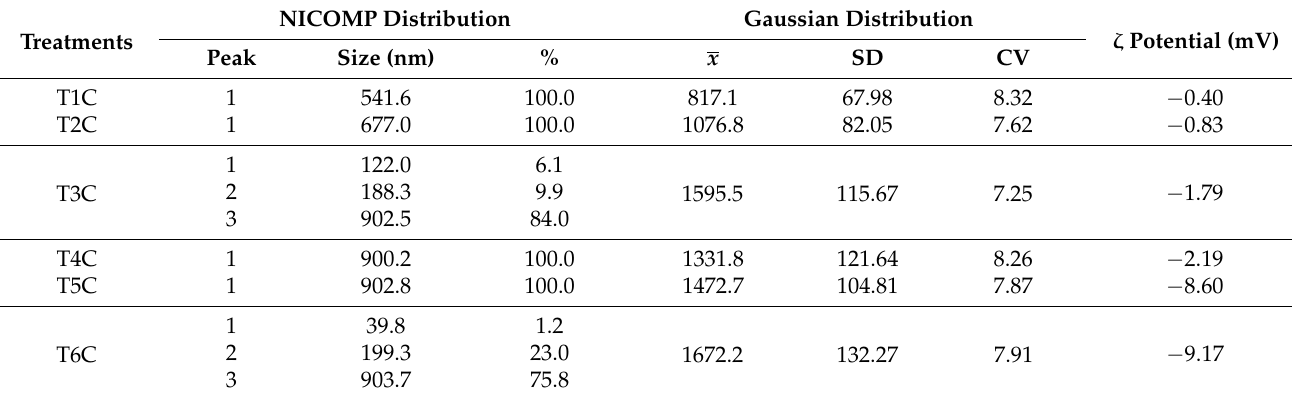
Table 5. Particle size and ζ